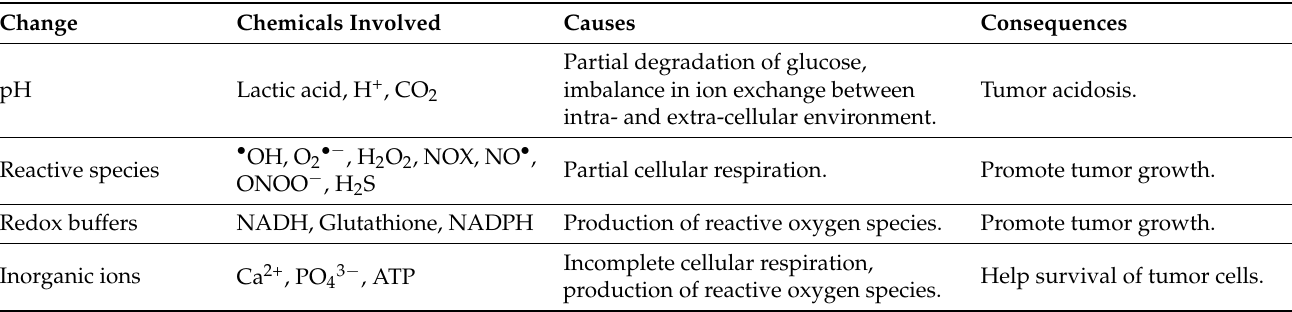
Table 1. Summary of hypoxia-mediated pathophysiological changes in tumor